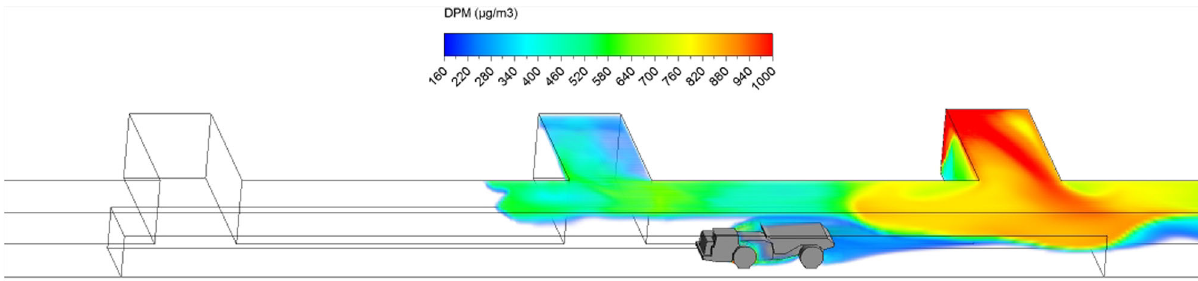
Fig. 9 DPM distributions in scenario 1 during the loading operation at 180 s